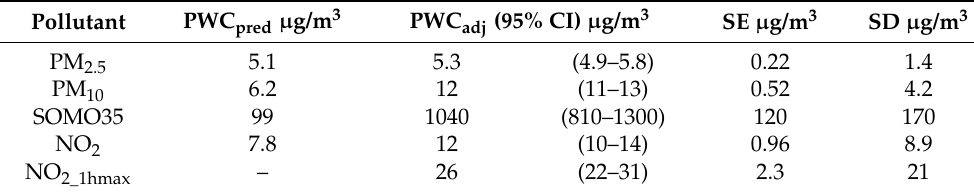
Table 4. Adjusted population-weighted concentrations (PWC adj ) in Finland in